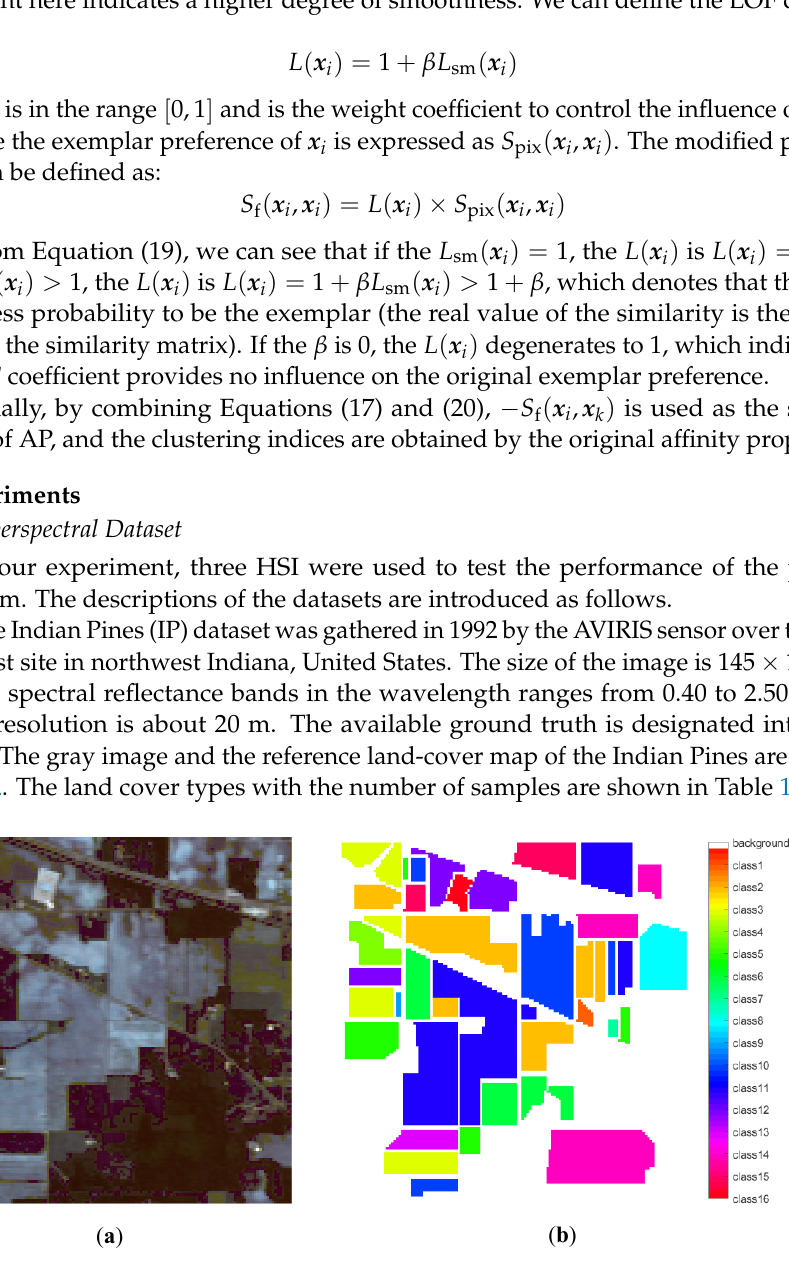
Figure 2. The Indian Pines dataset. ( a ) RGB image (band 10, 20, 30). ( b ) Reference land-cove map (16 classes). Table 1. Land cover type with the number of samples for the Indian Pines dataset.